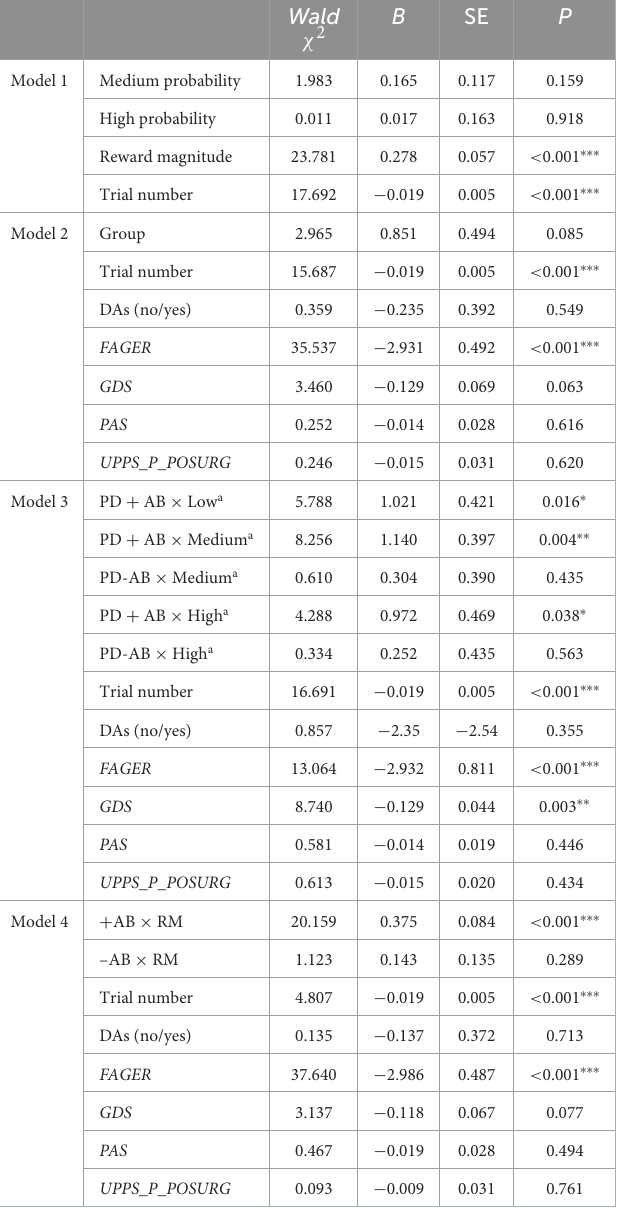
TABLE 2 Predicting hard task choice with task features, group, and demographic covariates across four